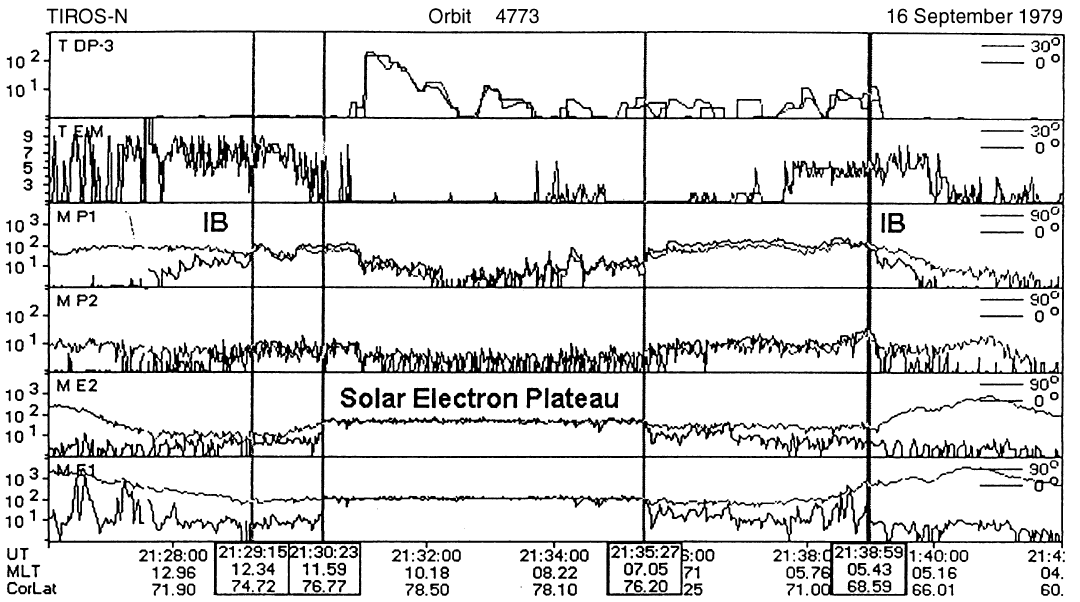
Fig. 9. Same as in Fig. 7 but for the case with large fluxes of energetic solar electrons. To facilitate the visualization of the solar electron flux plateau in the high-latitude region, here we also added data from >100 keV electron channel ( E